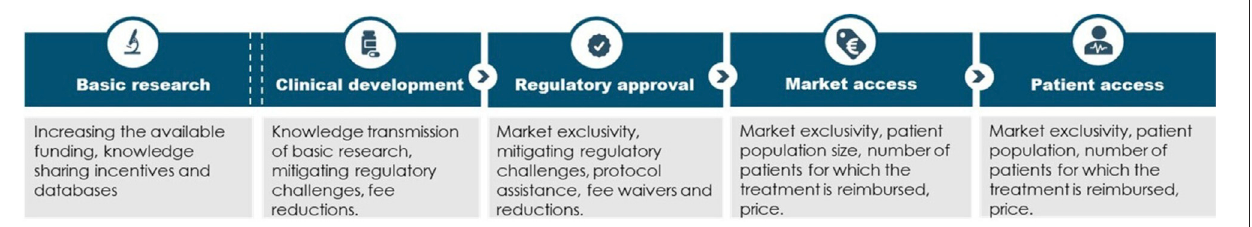
FIGURE 1 | Incentives for OMP development. Source: The OD Expert Group